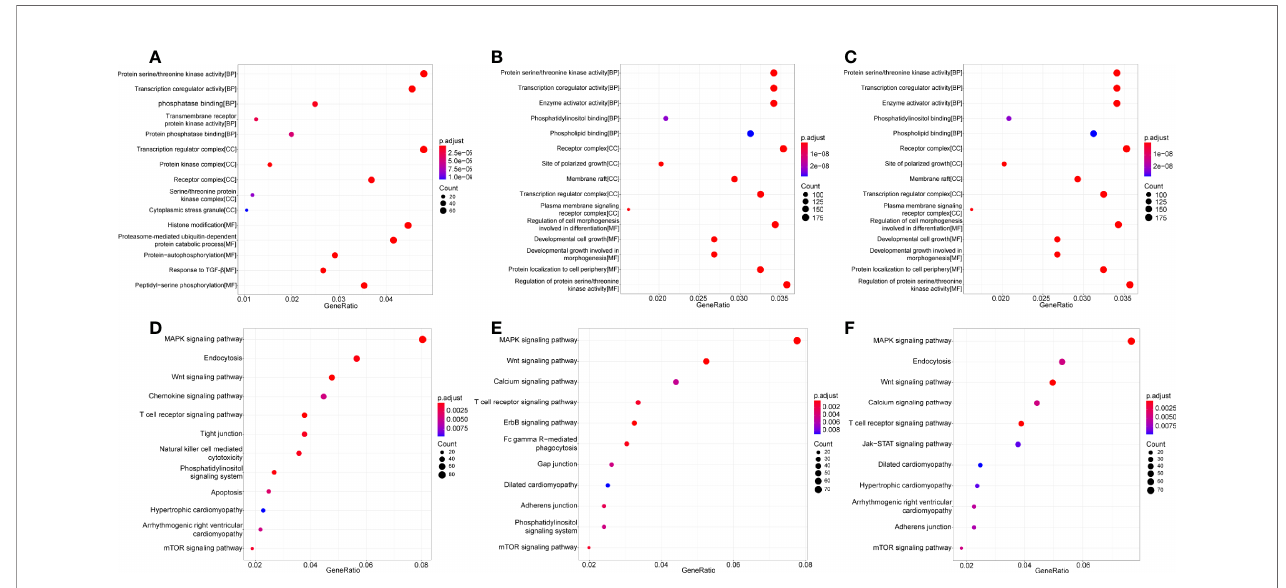
FIGURE 6 | GO and KEGG enrichment analysis of signi fi cantly dysregulated miRNAs in heart tissues. (A – C) GO enrichment analysis of signi fi cantly dysregulated miRNAs in heart tissues. (D – F) KEGG enrichment analysis of signi fi cantly dysregulated miRNAs in heart tissues.